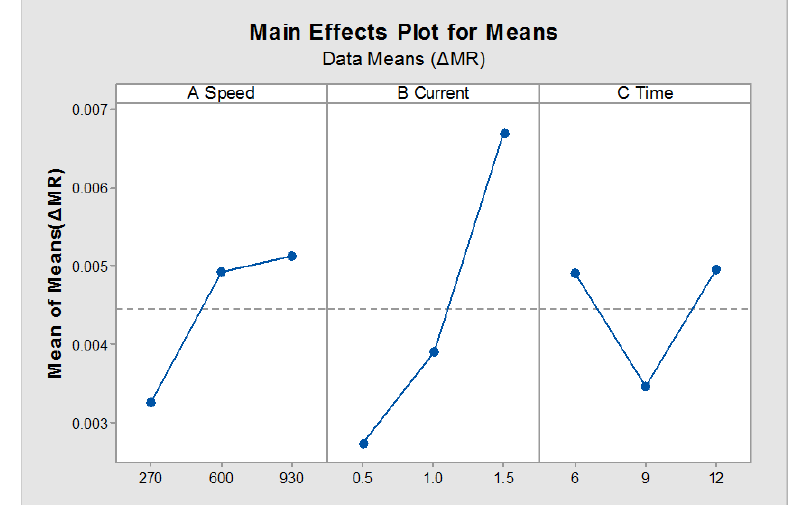
Fig. 8. Plots of Parameters Main Effect Verses Mean